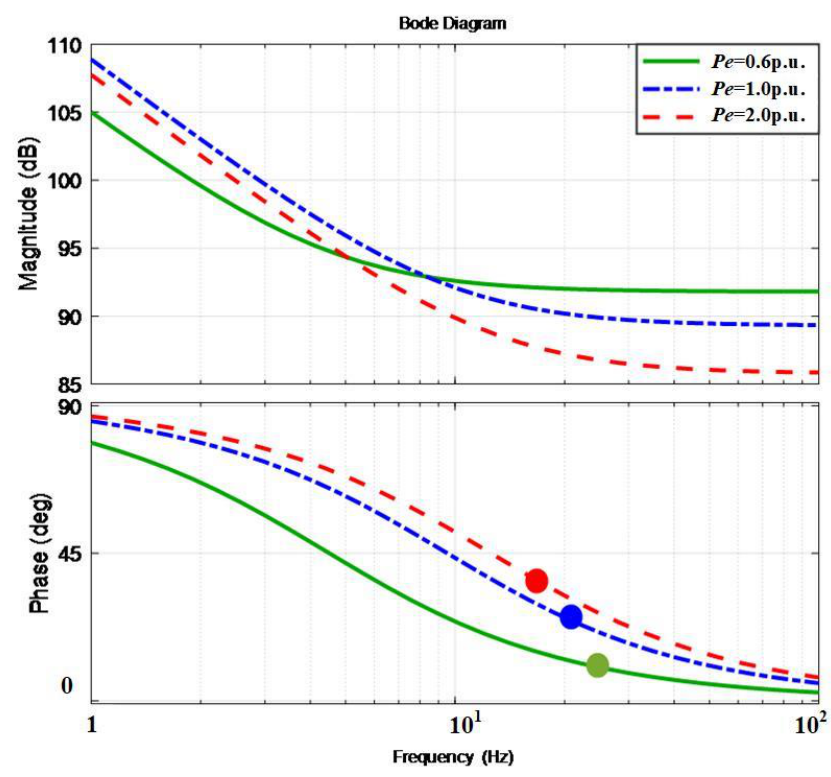
Figure 9. Bode diagram of G 1 ( s ) for different operating points.